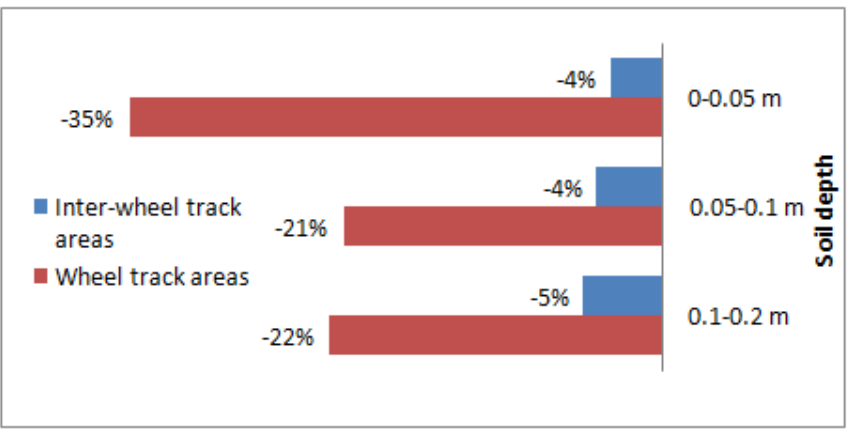
Figure 5: Electrical Resistivity profiles in the transect (using inverted RES2DINV), before and after machinery operations